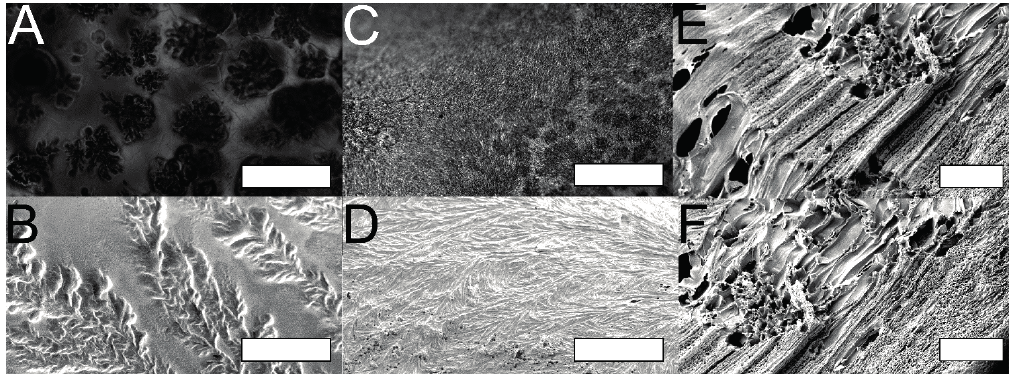
Figure 3. ( A ) Brightfield microscope image of urea crystal-templated silk films from solution in formic acid (scale bar, 600 μ m); ( B ) SEM image of urea crystal-templated silk films formed from solution in formic acid (scale bar, 200 μ m); ( C ) Brightfield microscope image of urea crystal-templated silk films formed from solution in hexafluoroacetone hydrate (scale bar, 600 μ m); ( D ) SEM image of urea crystal-templated silk films formed from solution in hexafluoroacetone hydrate (scale bar, 100 μ m); ( E ) SEM image of urea crystal-templated silk films formed from solution in hexafluoroisopropanol (scale bar, 100 μ m); and ( F ) SEM image of urea crystal-templated silk films formed from solution in water (scale bar, 100 μ m). Images are representative of at least 3 locations on 3 samples.